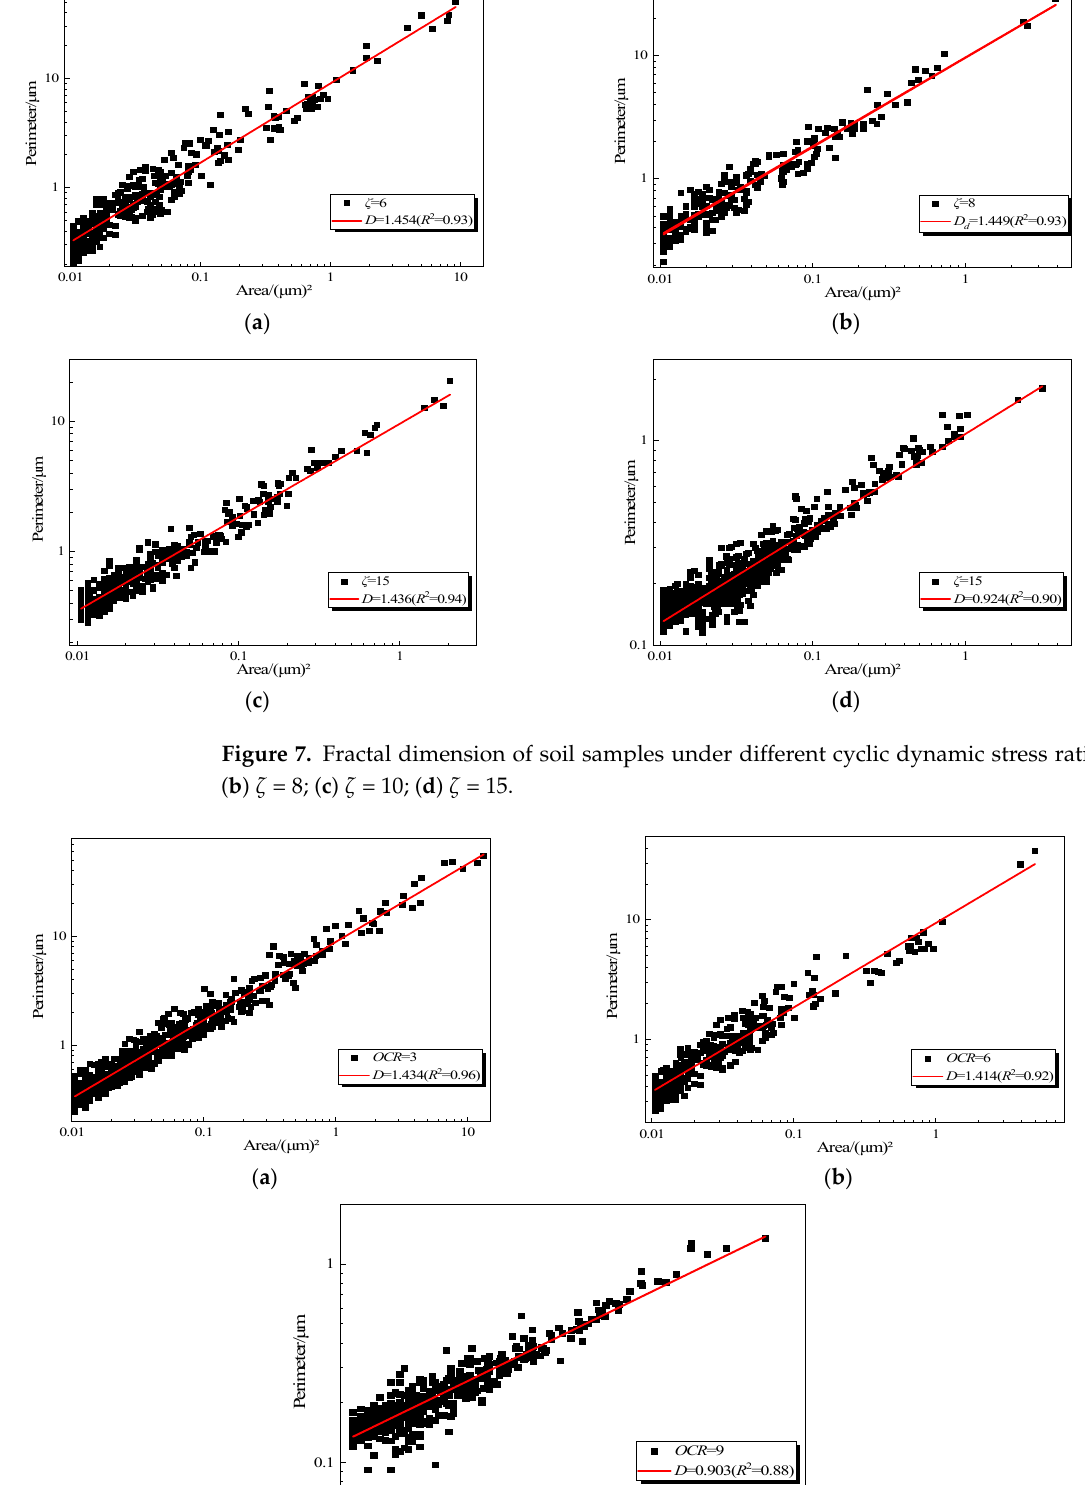
Figure 6. Fractal dimension of soil samples under different pressure: ( a ) before loading; ( b ) p 0 = 100 kPa; ( c ) p 0 = 200 kPa; ( d ) p 0 = 300 kPa; ( e ) p 0 = 400 kPa; ( f ) p 0 = 500 kPa.